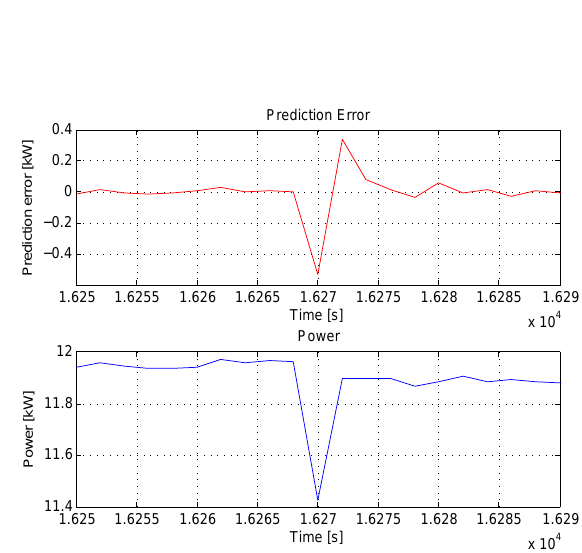
Figure 4: Residuals, e , (upper) and measured power, ∆ P , (lower) zoomed in at the left-most arrow in Figure 3.